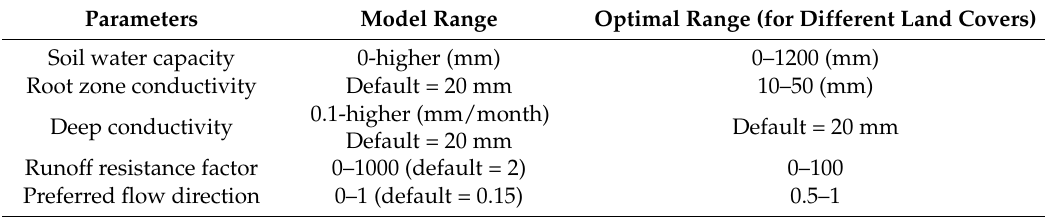
Table 2. The calibration parameter ranges used in the Water Evaluation and Planning (WEAP)